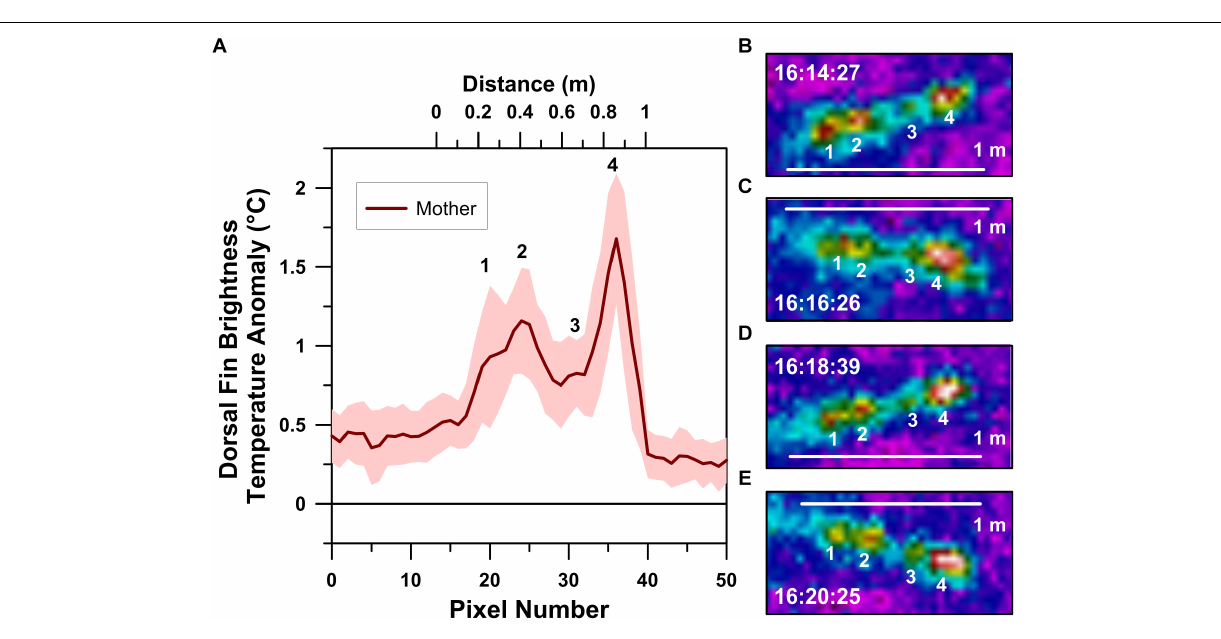
FIGURE 3 | Thermographic profile of a logging mother humpback whale’s dorsal fin (A) . Local maxima in the profile, labeled 1–4, correspond with the numbered dorsal fin hot-spots recognized in infrared spectrum images collected ∼ 2 min apart and at 20 m altitude (B–E) . Clock times indicated in B–E are in Cook Island Time during the afternoon of August 26,